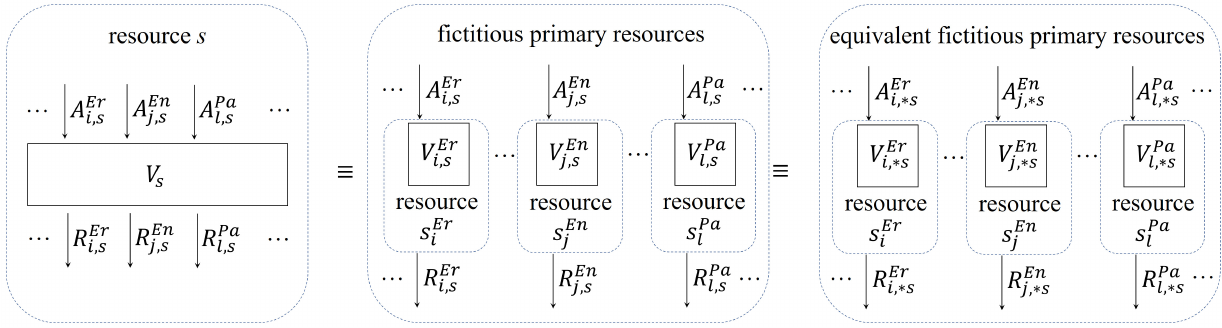
Figure 2. Decomposition of the primary resource s into m s fictitious primary resources and m s equivalent fictitious primary